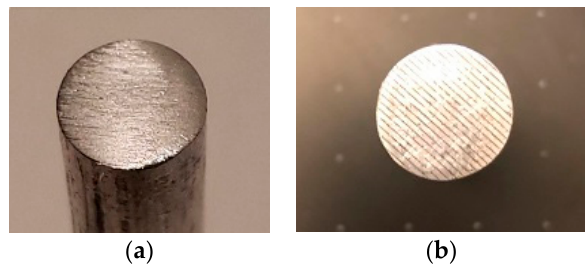
Figure 7. Manufactured rod samples: ( a ) smooth and ( b ) grooved.